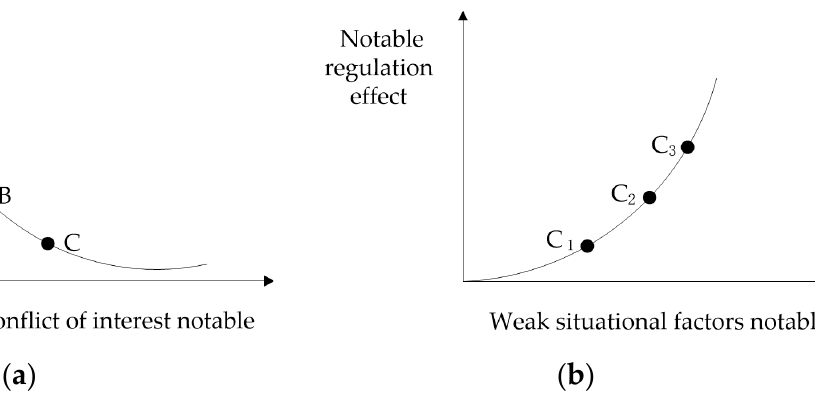
Figure 4. The regulatory mechanism. ( a ) The relationship between regulation effect and conflict of interest; ( b ) The relationship between regulation effect and situational factors.